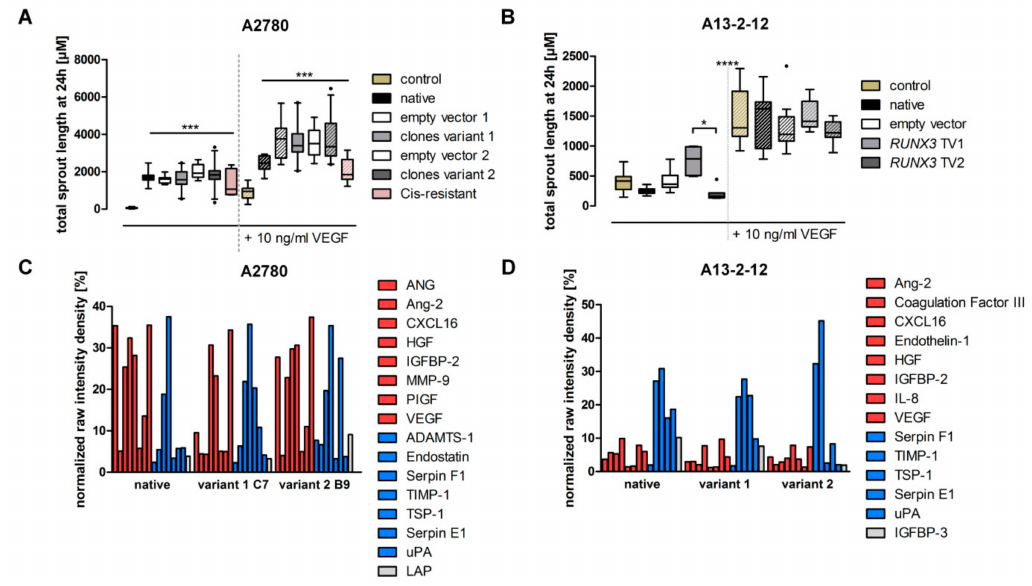
Figure 6. RUNX3 transcript variant’s effect on the angiogenic effect of EOC cell supernatant. ( A ) Using conditioned media (CM) derived from A2780 cells, considerable amounts of HUVEC sprouting was detected. CM of native A2780 alone led to a 14-fold increase in the amount (Supplementary Figure S5) and a 2-fold increase in sprout length resulting in a 30-fold higher effect compared to RPMI + 2% FSC control. The overexpression RUNX3 had no effect on the sprouting compared to the native A2780 cells. After the addition of 10 ng/mL vascular endothelial growth factor (VEGF), the CM effect (3-fold increase) was still visible. n spheroid ≥ 7. ( B ) The CM from A13-2-12 cells showed a reduced angiogenic potential similar to the control. The addition of 10 ng/mL VEGF led to a significant increase in formed sprouts. While induction of human umbilical vein endothelial cells (HUVEC) sprouting was seen upon incubation with CM from RUNX3 TV1 expressing A13-2-12 cells, the effect was not significant compared to the empty vector control. The reduction of the sprouting caused by RUNX3 TV2 CM was also not statistically significant, while the difference between the two variant CM did differ. n spheroid ≥ 8. * p < 0.05, *** p < 0.001, **** p < 0.0001 in 2-way ANOVA. ( C , D ) Normalized raw intensity data from the Proteome Profiler™ array. Only proteins with signals above the background are shown. Based on current publications, the regulators were either defined as an activator (red), inhibitor (blue) or indifferent (gray). Signals were normalized against the raw intensity of the reference spots on each blot, respectively. Signal quantification of A2780 CM showed more activators than inhibitors, and specifically, high amounts of VEGF were detected ( C ). Quantification of signals from A13-2-12 CM showed higher signal intensities of inhibitory proteins ( D